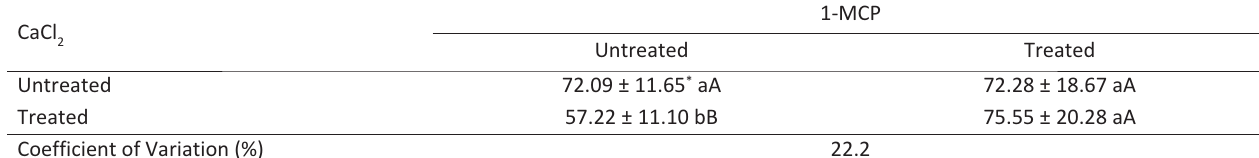
* Standard deviation. Values followed by the same uppercase letter in a column and lowercase letter in a row are not significantly diffe­ rent from each